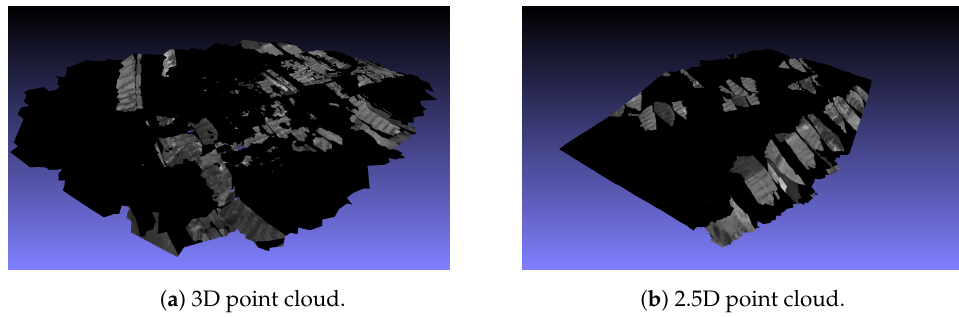
Figure 28. Point cloud models obtained from the processing of images from a single band, in this case the blue